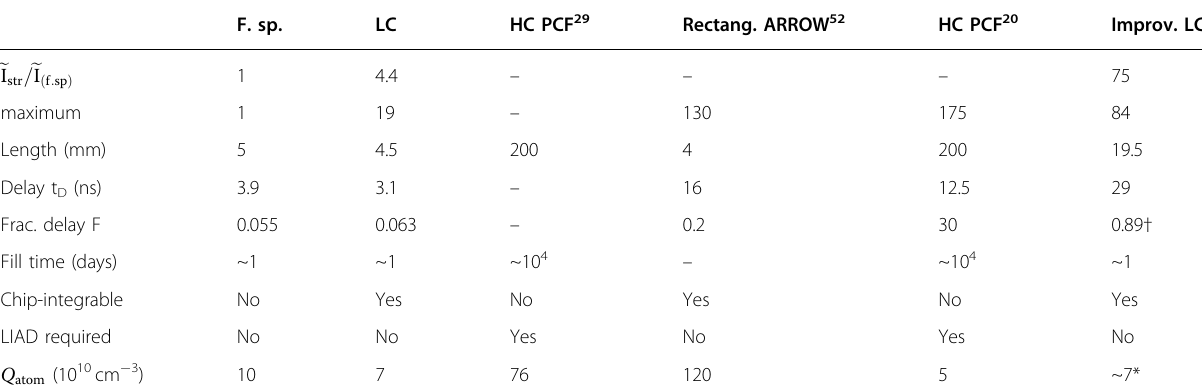
Table 1 Comparative overview on light delay in different types of